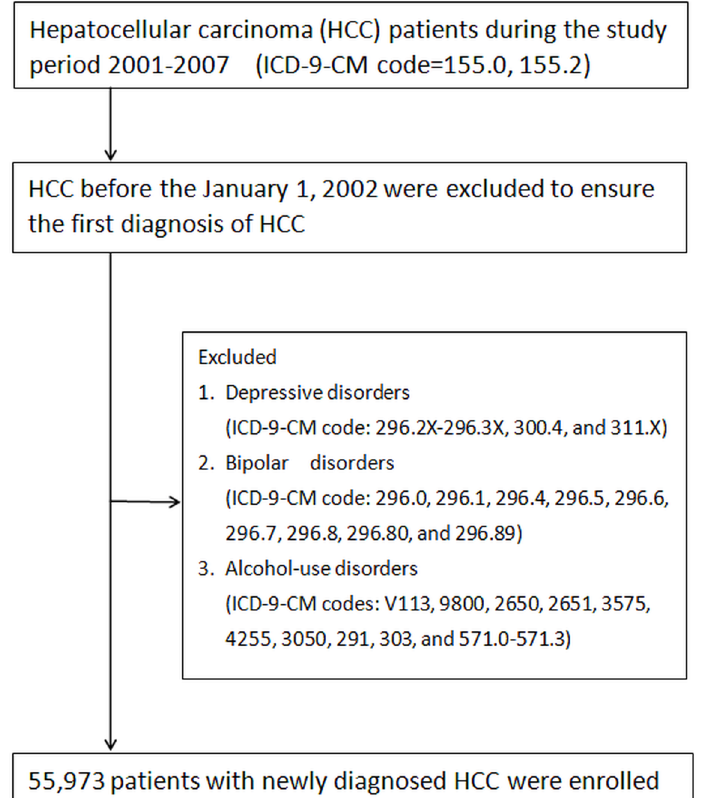
Fig 1. Selection of study